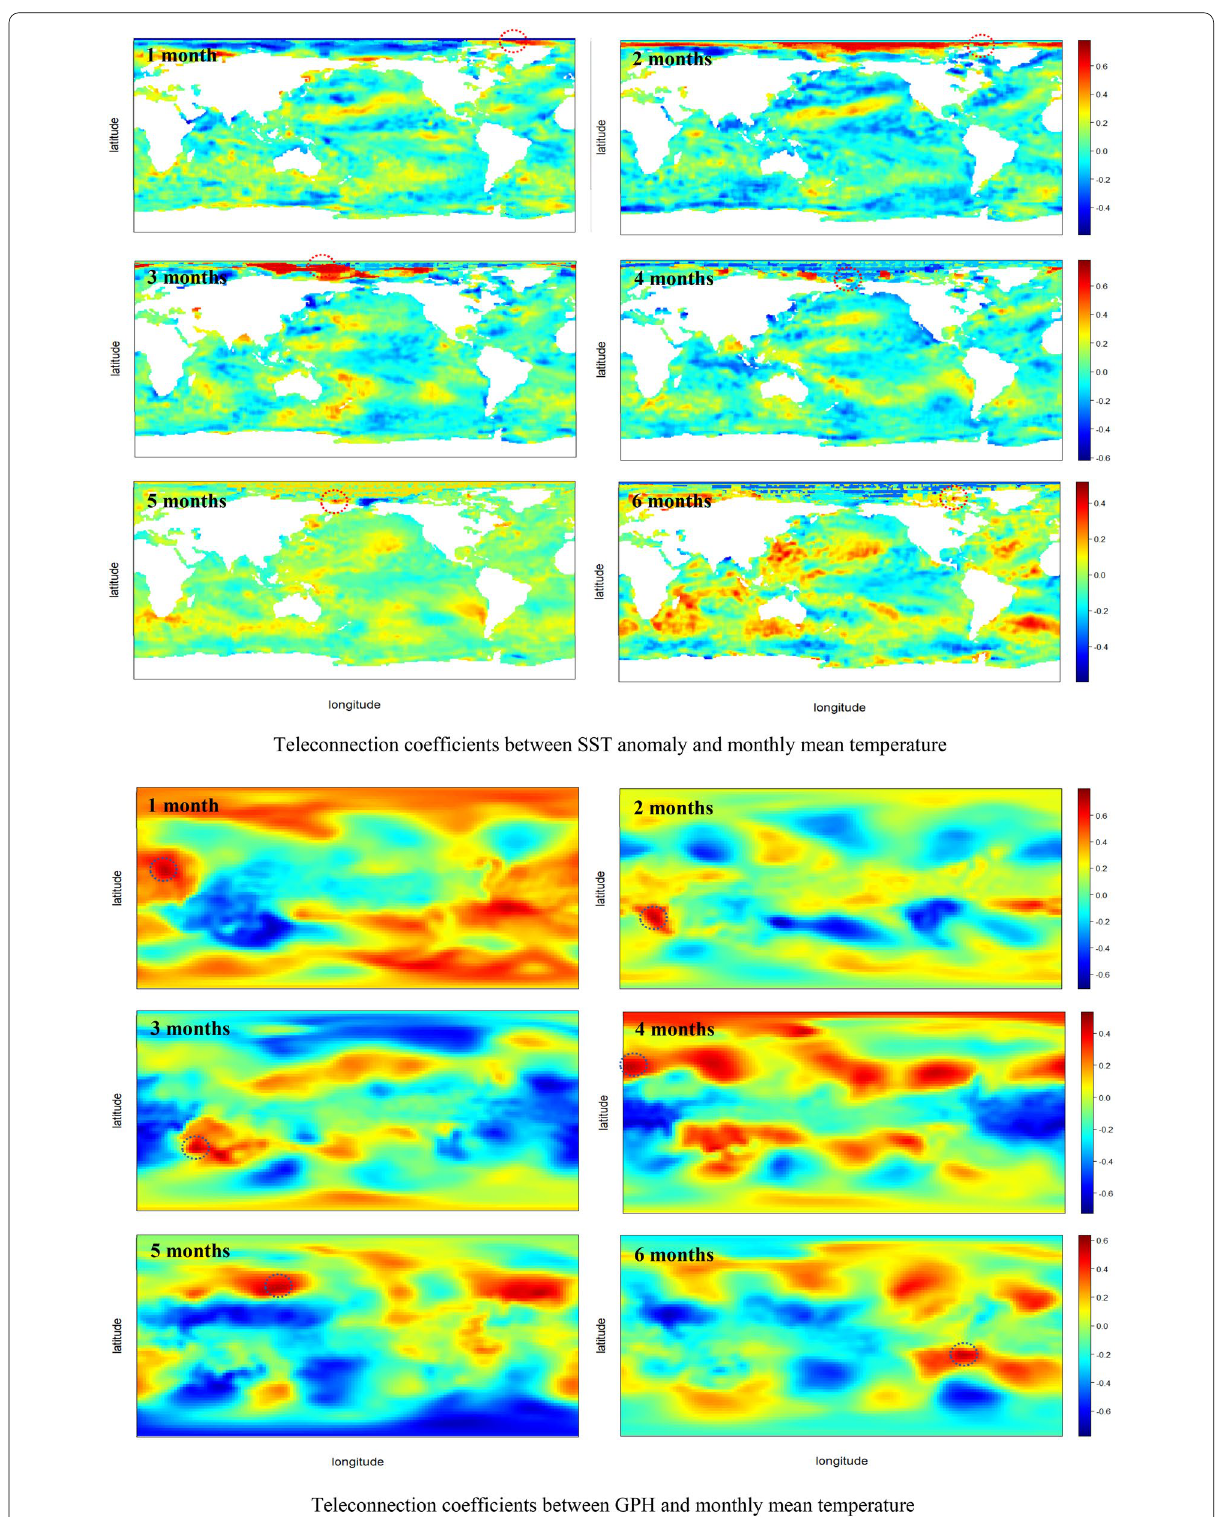
Fig. 30 Teleconnection coefficients between the global-scale climate indices and monthly mean temperature during the neutral